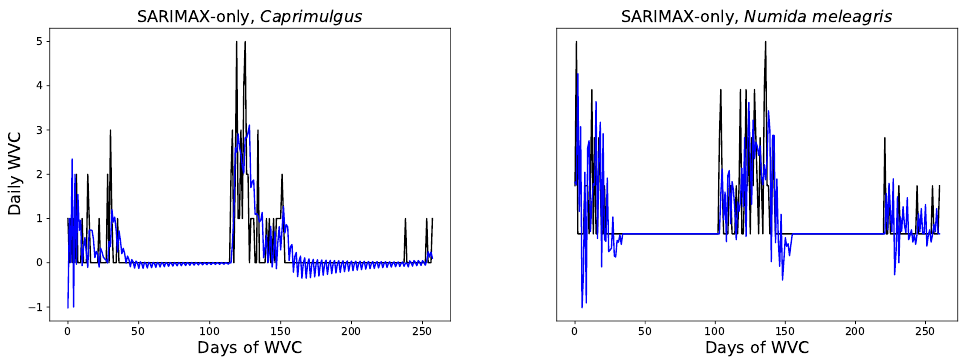
Figure 9. A time series of daily wildlife roadkill showing actual data and predicted data using SARIMAX-only on the Aves (top-left panel), Mammalia (top-right panel), Caprimulgus (bottom-left panel), and Numida meleagris (bottom-right panel) datasets.